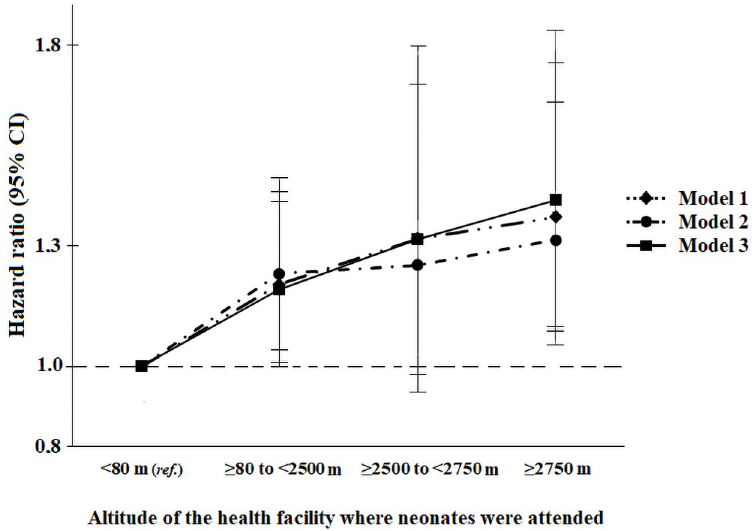
Fig 1. Adjusted hazard ratios of the incidence rate of death per each altitude stratum according to three mixed- effects multivariate Cox proportional hazards models, considering the reference an altitude of the health care facility where neonates were attended of < 80m. Estimated hazard ratios from mixed-effects multivariate Cox proportional models. All models (1, 2 and 3) estimated fixed effects for next individual variables: gestational age, birth weight, Apgar scale at five minutes, and comorbidities; and random effects for contextual variables in this way: (i) administrative planning areas, type of health care facility, and level of care in Model 1, (ii) administrative planning areas, and level of care in Model 2; and (iii) level of care in Model